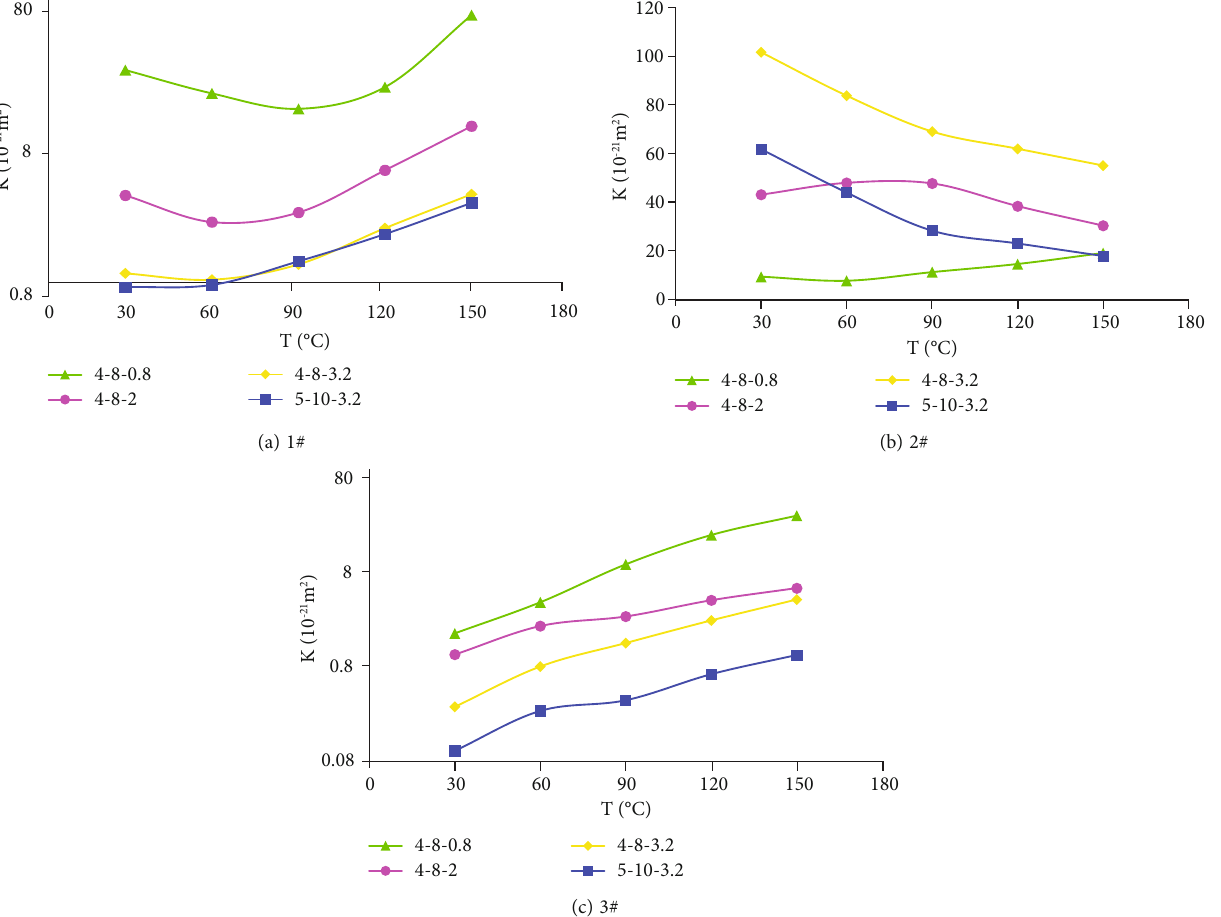
Figure 5: Relationship between coal permeability and temperature under di ff erent stress